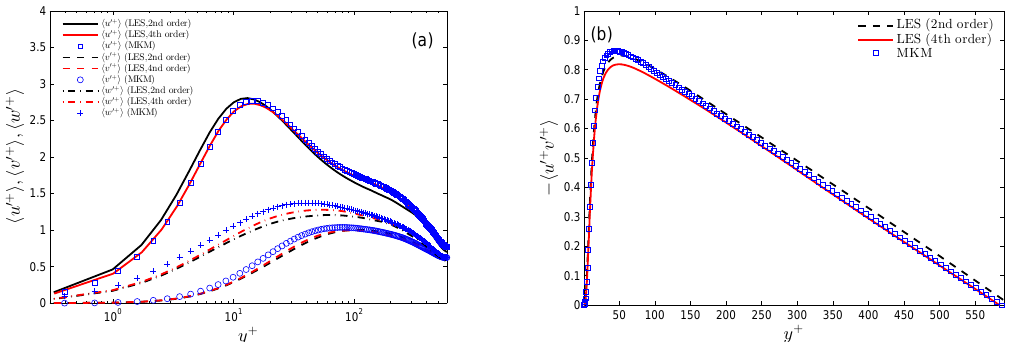
Figure 12. ( a ) R.m.s of velocity fluctuations and ( b ) tangential Reynolds stress of turbulent channel flow by LES at Re τ =